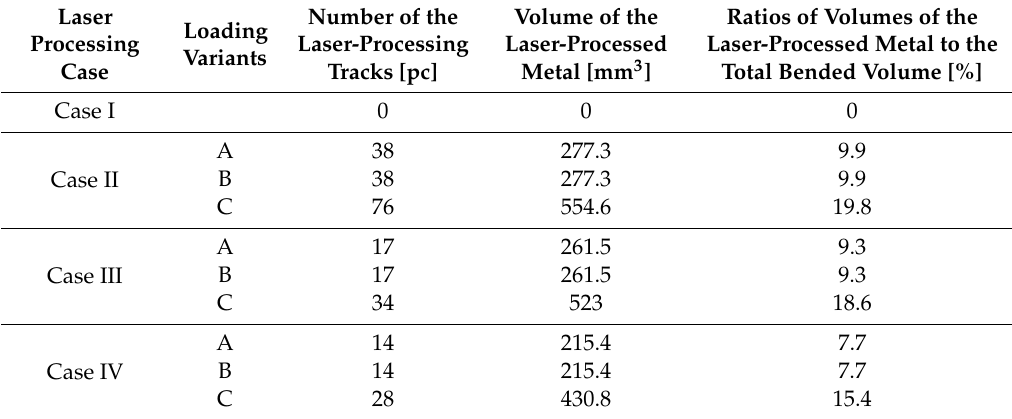
Figure 3. Part ( a ) shows: geometry, dimensions, stand and the loading scheme of the laser-processed plate of the numerical model of the bending simulation; and in ( b ): σ b denotes the base metal σ − (cid:15) curve; ˆ σ b denotes the bilinear approximations of σ b ; ˆ σ l denotes the bilinear approximation of the σ − (cid:15) curve of unknown laser-processed metal; yield strengths, ultimate strength, and fracture strains of the base metal and the laser-processed metal are denoted by σ 0.2, b , σ 0.2, l , σ B , b , σ B , l , (cid:15) ul , b and (cid:15) ul , l respectively. Table 6. The laser processing and variants of geometry of the laser-processed area and bending